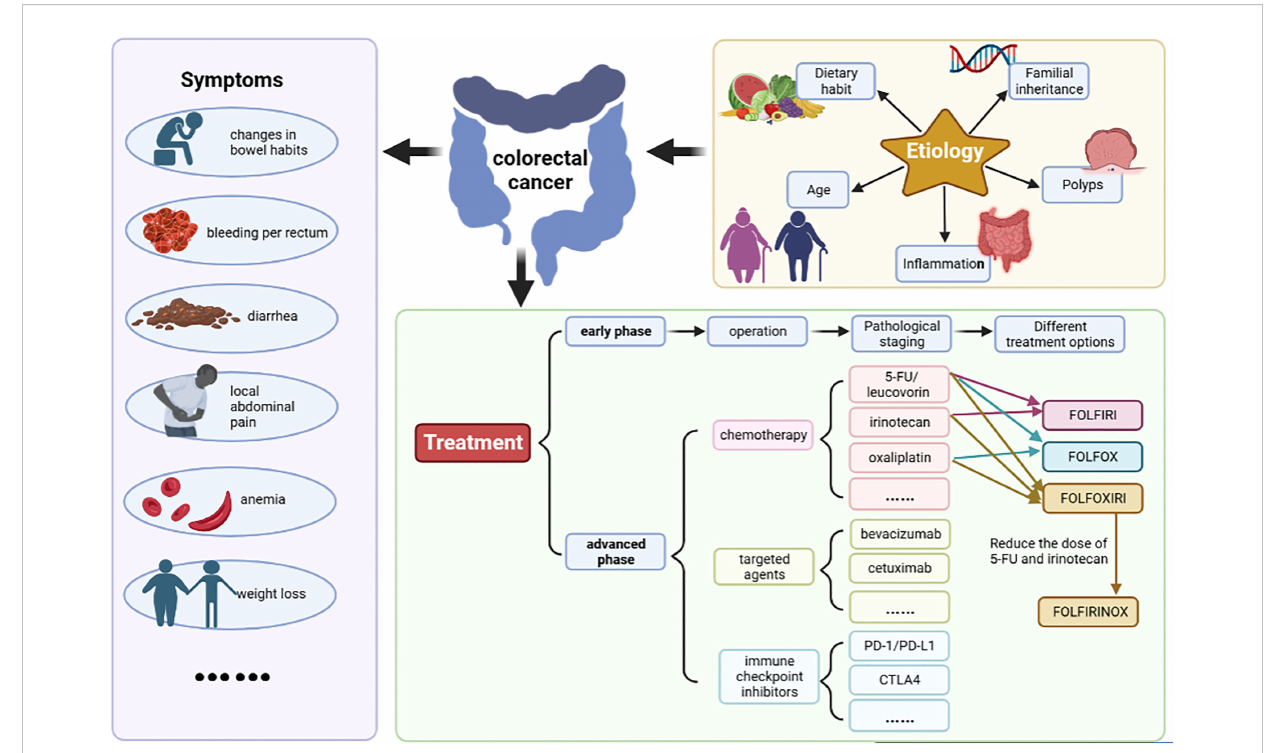
FIGURE 1 The symptoms, etiology and treatment of CRC. The symptoms include changes in bowel habits, bleeding per rectum, diarrhea, local abdominal pain, anemia and weight loss etc. At present, the etiology of CRC is not completely clear. It is generally believed that dietary habit, familial inheritance, polyps, in fl ammation, age are closely related to the disease. Surgery is the preferred treatment for patients with early-stage CRC. Commonly used chemotherapy drugs mainly include 5- fl uorouracil (5-FU)/leucovorin (LV), irinotecan, and oxaliplatin etc. Targeted therapeutic drugs mainly include cetuximab and bevacizumab. Basic chemotherapy regimens included FOLFIRI (irinotecan+5-FU+LV), FOLFOX (oxaliplatin+5-FU+LV), FOLFOXIRI (oxaliplatin+irinotecan+5-FU+LV) and its modi fi ed regimen FOLFIRINOX (reduced doses of irinotecan and